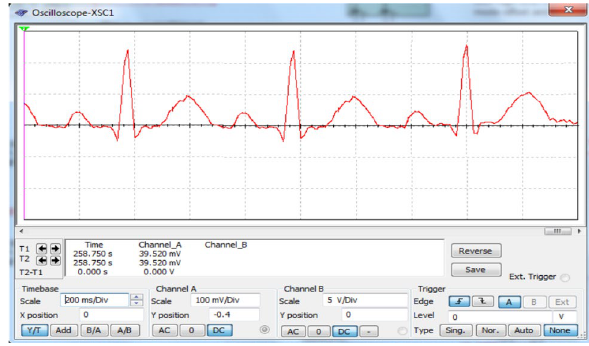
Fig. 11 Schematic design test in